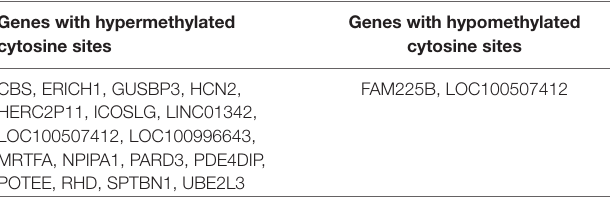
TABLE 3 | Gene list of hyper- and hypo-methylated cytosine sites for MDD vs. control. Genes with hypermethylated cytosine sites